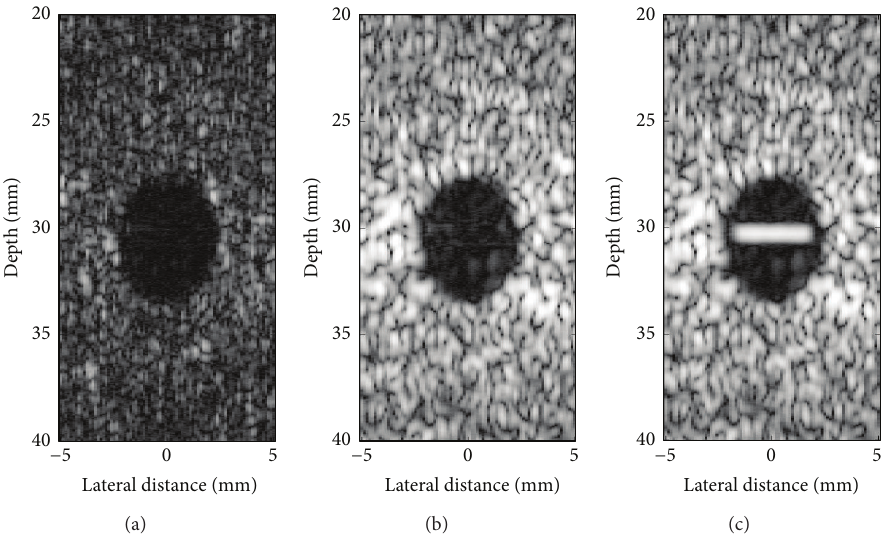
Figure 5: Clutter reduction using MCA on IQ data of simulation images when the cut-off 𝛽 was set to (a) 0.5, (b) 0.75, and (c) 1.